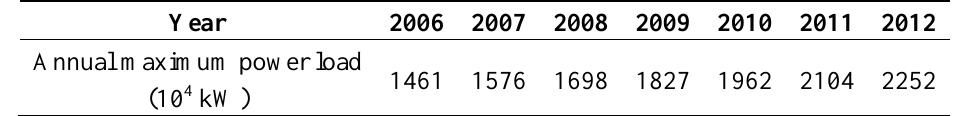
Table 1. Power load forecasting result of the logistic curve model.